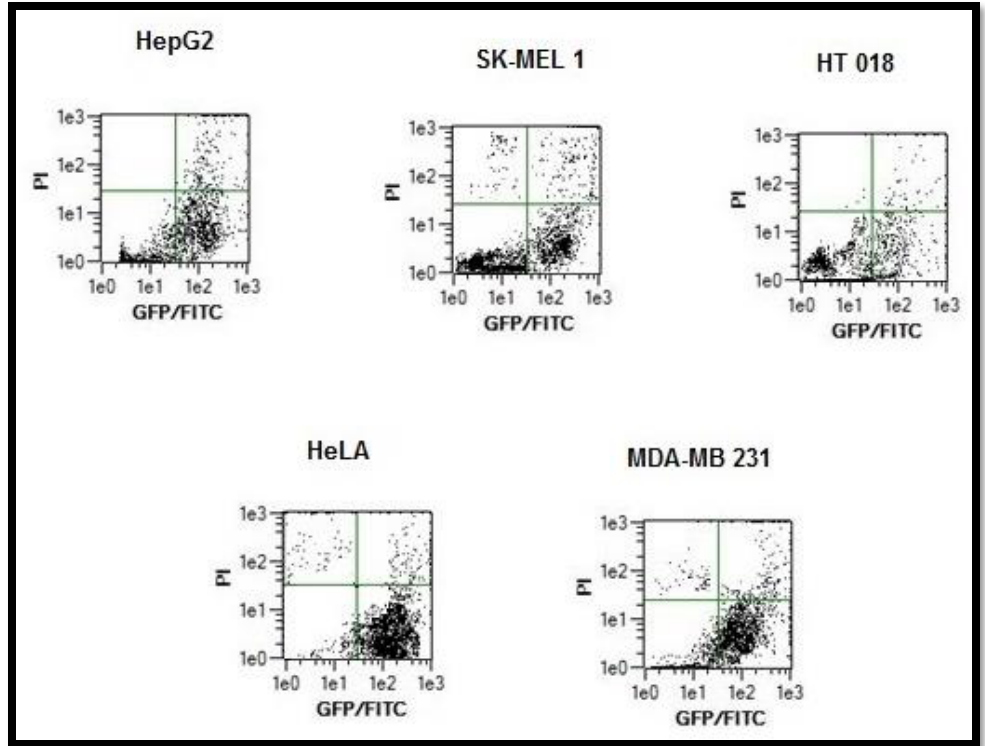
Figure 8. The apoptotic effect of complex 3 using Annexin-V staining of tested cancer cell lines. Dots represent cells as follows: lower left quadrant, normal cells (FITC − /PI − ); lower right quadrant, early apoptotic cells (FITC + /PI − ); upper left quadrant, necrotic cells (FITC − /PI + ); upper right quadrant, late apoptotic cells (FITC + /PI + ).